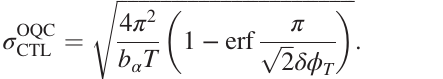
; n n with 3 ð n variational parameters. Markers en de Þ en þ de Þ